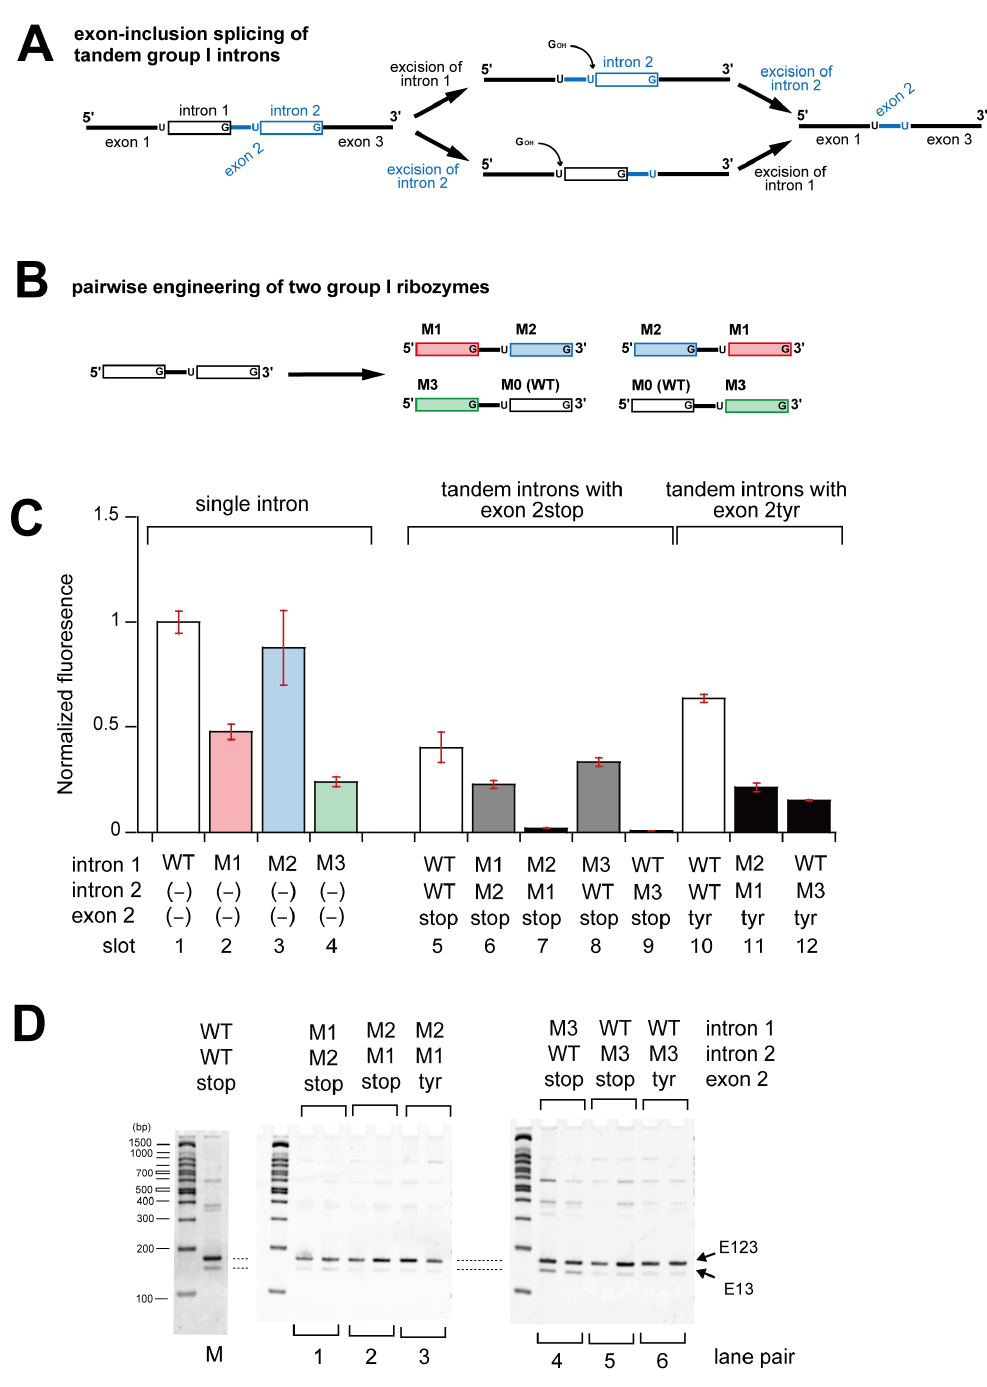
Figure 5. Rational engineering of tandemly aligned introns to induce exon-inclusion splicing. ( A ) Schematic representation of exon-inclusion splicing. Intron 1 and intron 2 carry out self-splicing independently. ( B ) Pairwise engineering of two group I introns to retain the splicing activity of each intron but eliminate the formation of a single active ribozyme cooperatively from intron 1 and intron 2. ( C ) β-Galactosidase reporter gene assays to evaluate the splicing activities of four precursors with WT as well as three variants and eight precursors with two introns and a short exon (exon 2) in E. coli . ( D ) RT-PCR assays to distinguish the ligated exons (E123 or E13) including or skipping exon 2, with lengths of 174 and 150 bp, respectively.